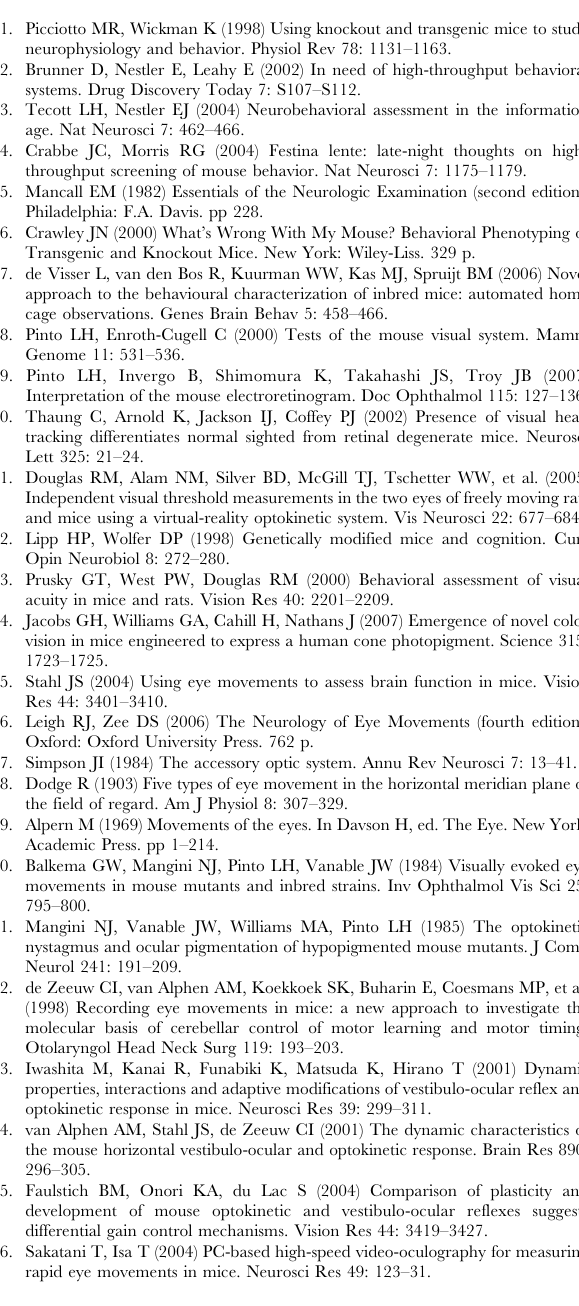
Figure S2 Relative gain in the slow component of the OKR as a function of percent contrast between the black and white stripes. Data are from the experiment shown in Figure 5A. Eye rotation is calculated based on a simplified model that places both the pupil image and the corneal reflections at the surface of the globe and assumes rotation about the center of a spherical globe (see Results section). A gain of 1.0 corresponds to an eye rotation that exactly tracks the